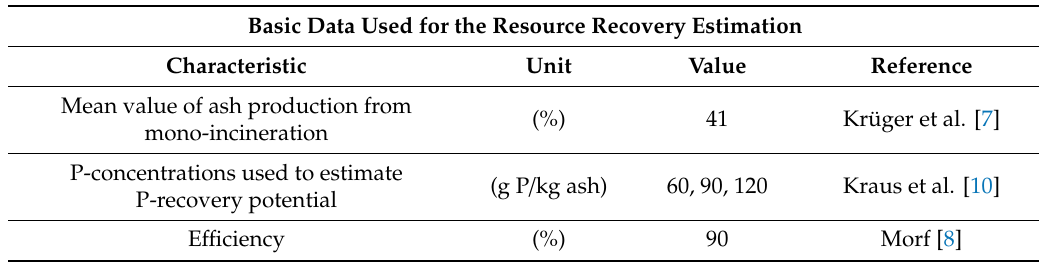
Table 2. Assumptions to estimate the amount of mono-incineration ash and phosphorus (P)-recovery potential.